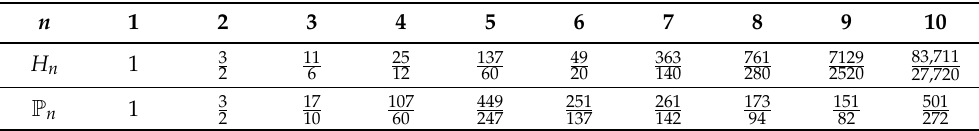
Table 1. Some harmonic and harmonic Pell